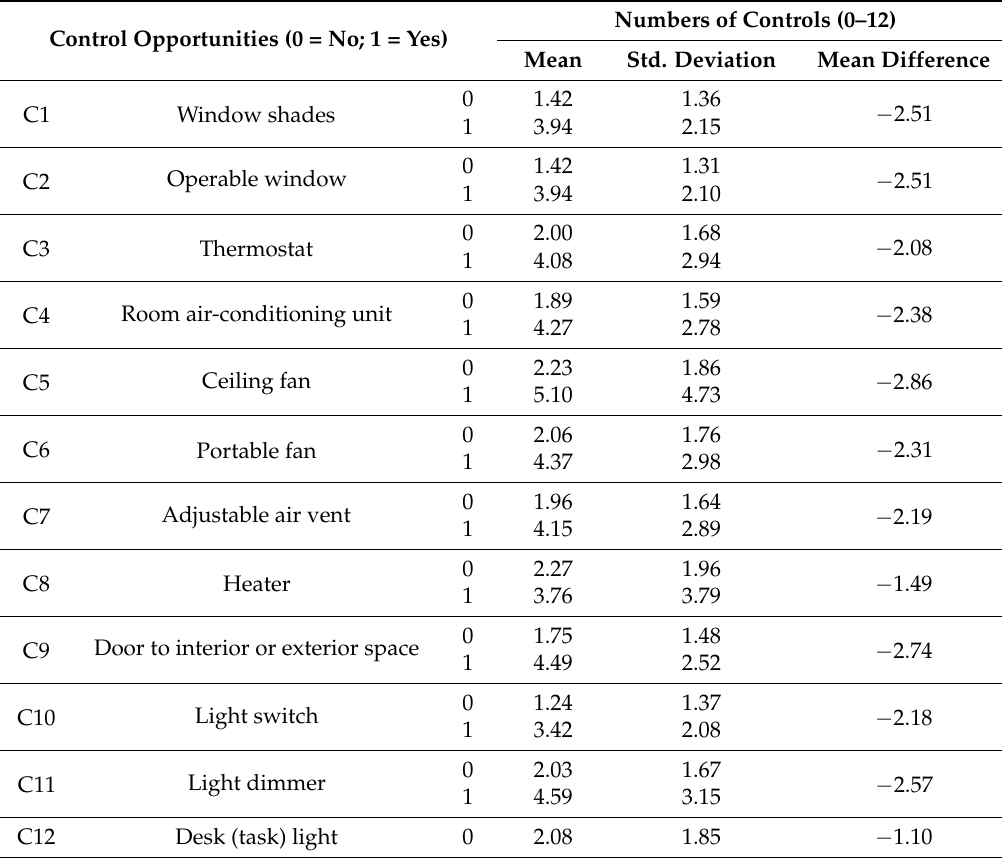
Table 4. Cross-table of different control opportunities and total numbers of controls.